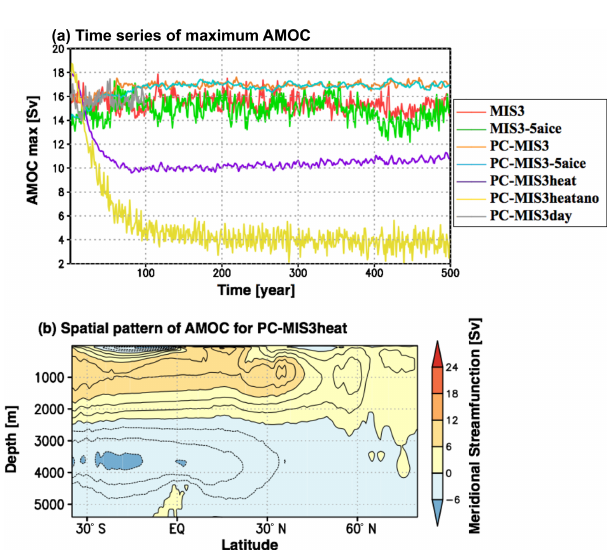
Figure 10. Results of the partially coupled experiment conducted with the AOGCM. (a) Time series of the maximum strength of the AMOC. (b) Spatial pattern of the Atlantic meridional stream- function calculated from PC-MIS3heat. The climatology of the last 100 years is used to create this